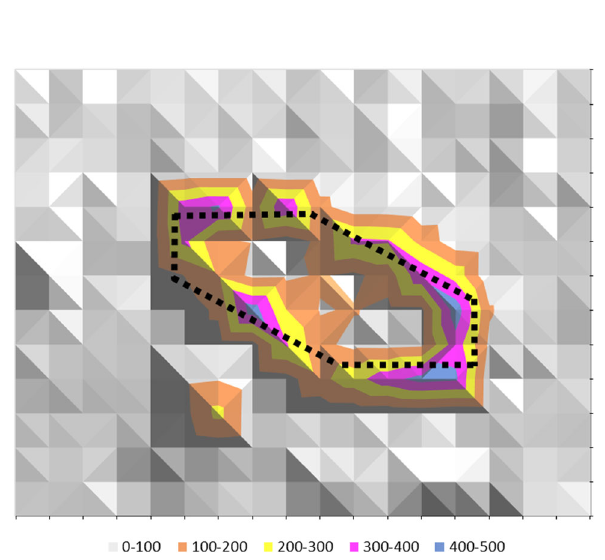
Fig. 7 Airflow velocities (ft./min) at 10-in. height underneath the canopy air curtain using Large Fan #3 & 0.212 m 3 /s (450 cfm). The black dashed line represents the perimeter nozzles of the